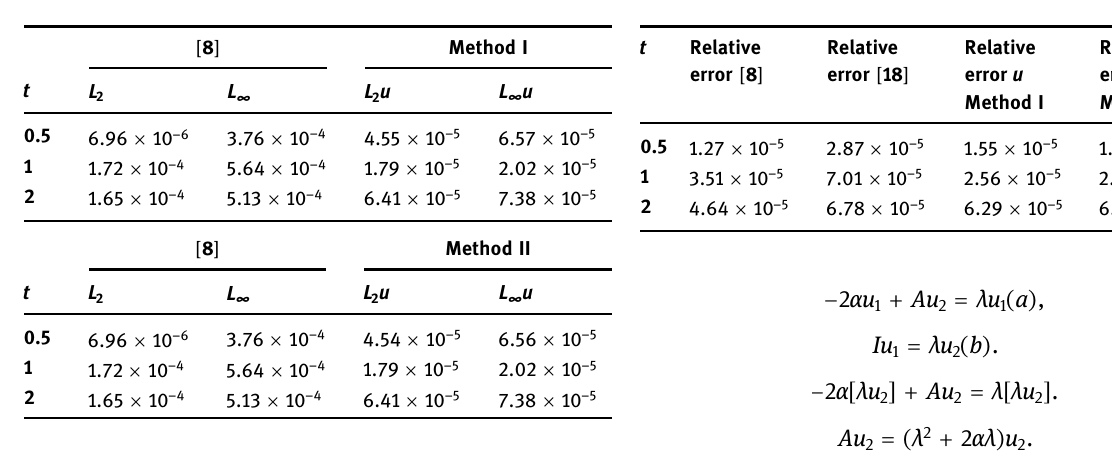
Table 22: Comparison of relative errors for = α 50 , = β 5 , = N 21